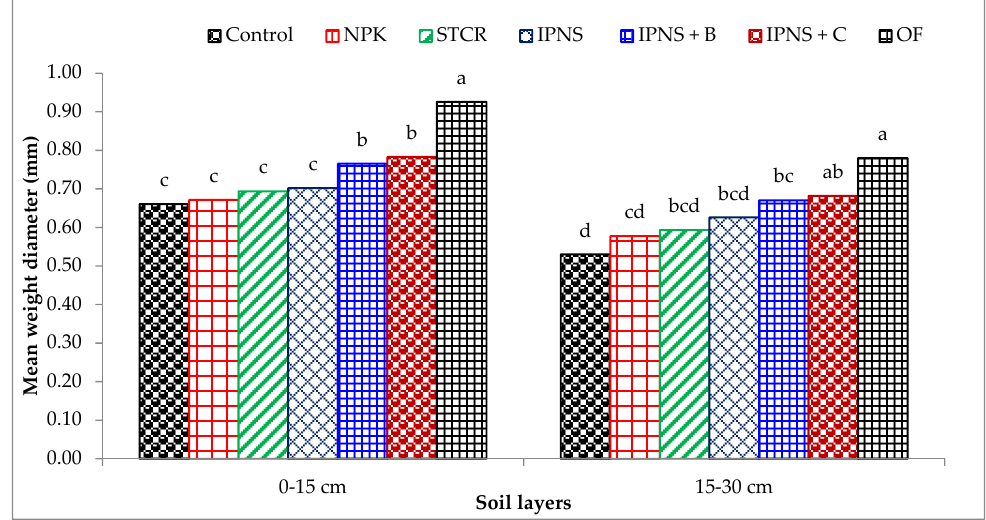
Figure 7. Effect of long-term nutrient supply options on mean weight diameter in the 0–15 and 15–30 cm soil layer of rice – wheat system. Means of different treatments followed by the different lower-case letters are significantly different at p < 0.05 level of significance according to DMRT.